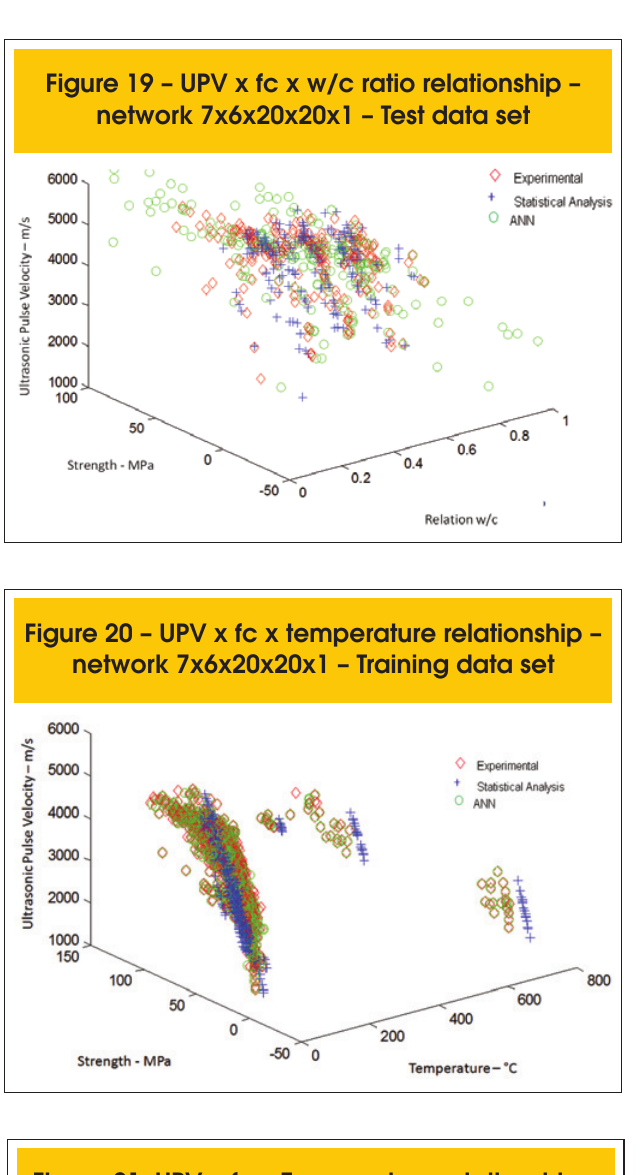
Figure 21: UPV x fc x Temperature relationship – network 7x6x20x20x1 – Test data set